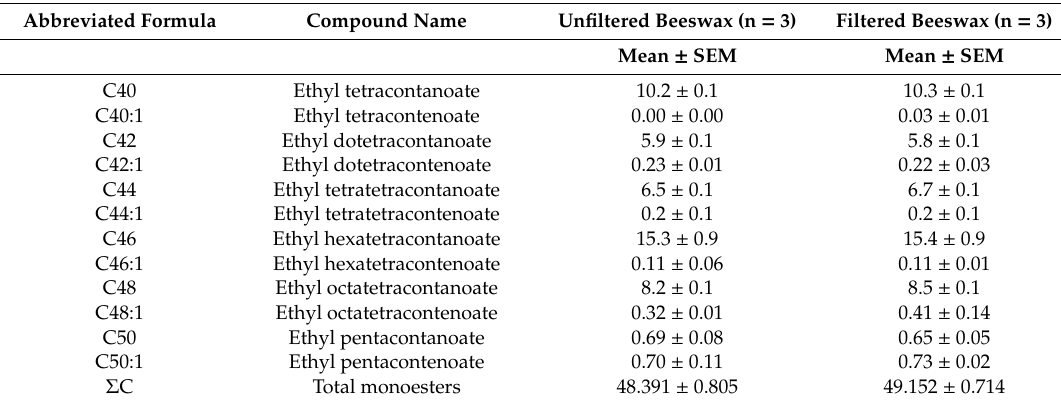
Table 3. Monoesters in beeswax (%) before and after the filtration